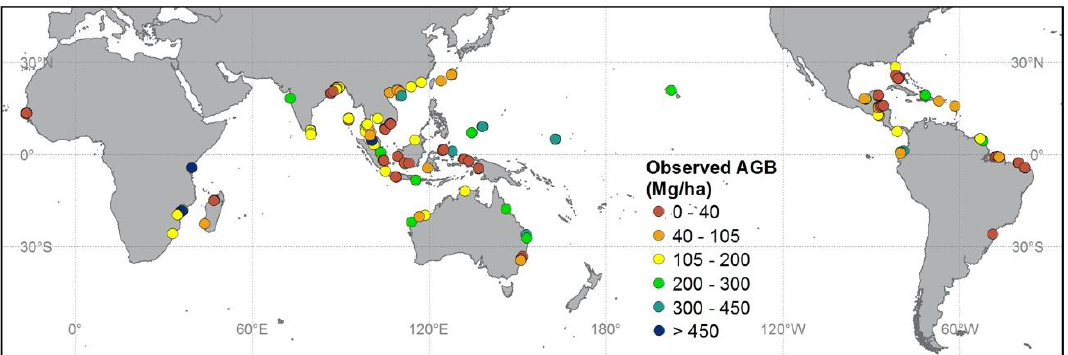
Figure 2. The collected mangrove plots distribution across the world. The color of each point indicated the value of aboveground biomass.